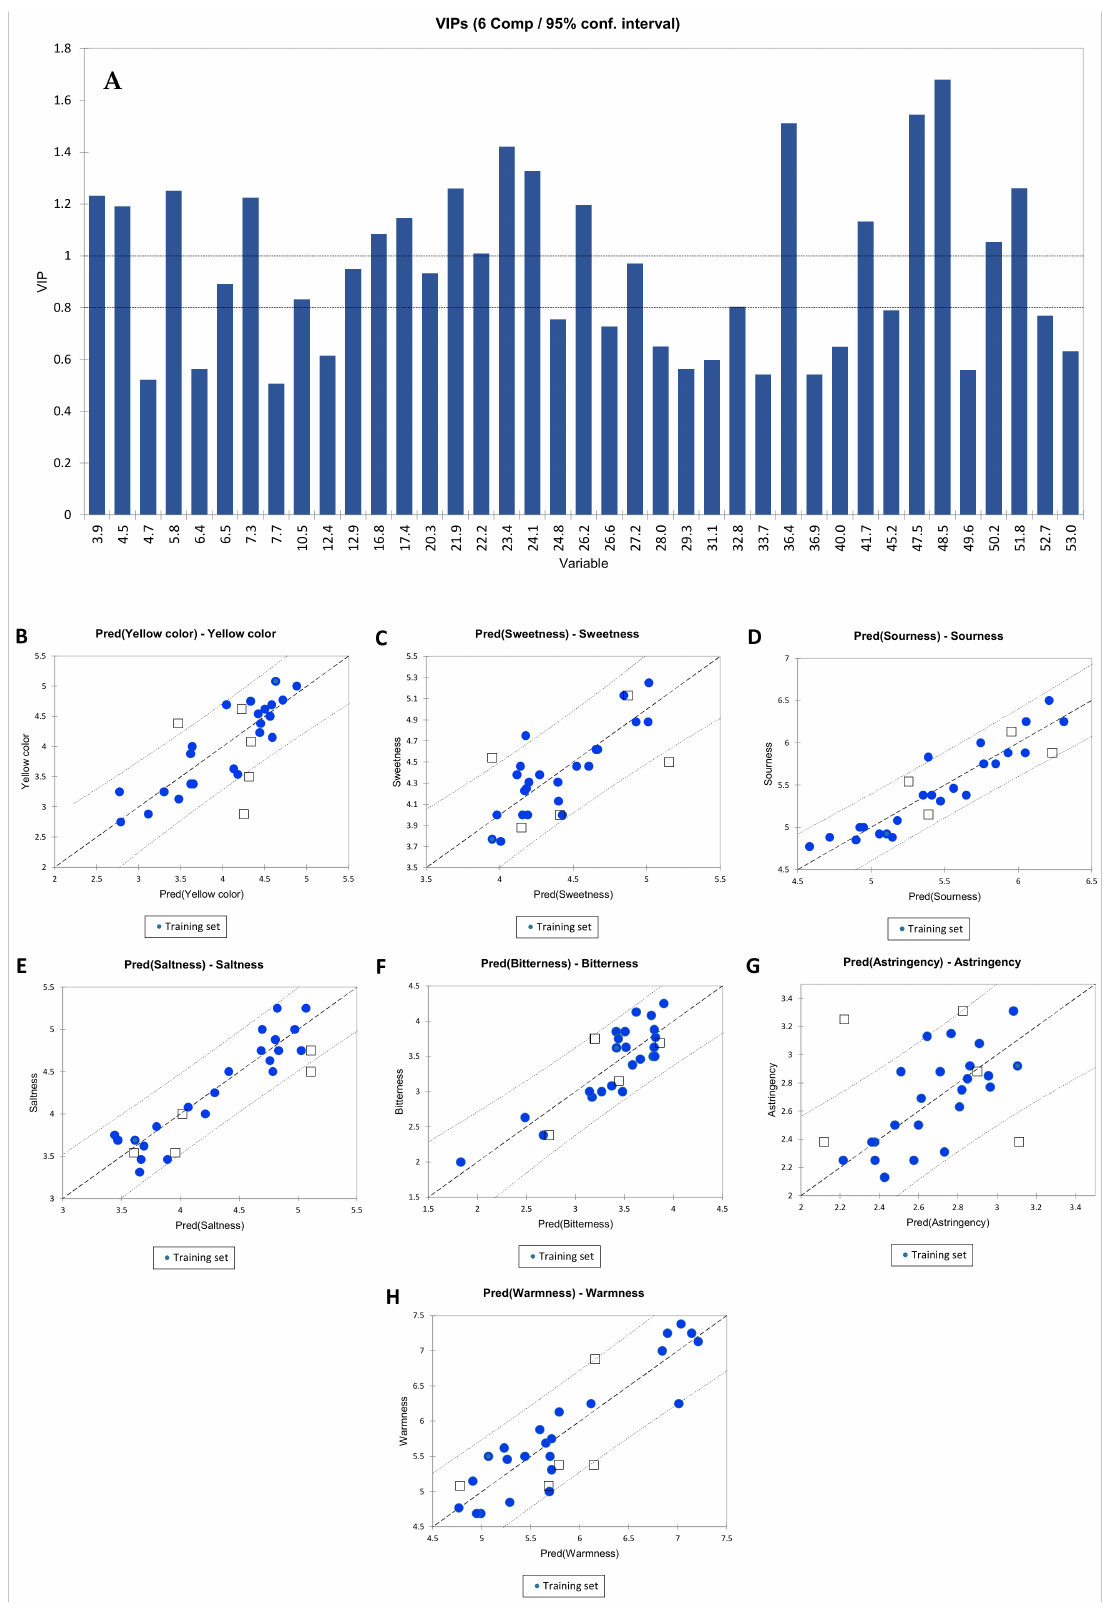
Figure 4. Partial Least Square Regression with multiple dependent variables (PLS2) for gustatoryand visual descriptors: ( A ) VIP (Variables Importance in Projection) at the component used for calculating the model; ( B to H ) Predicted/observed regression graph for visual and gustatory sensory descriptors (the confidence interval is set at 95%). Numbers of the X-axis are HPLC retention times of